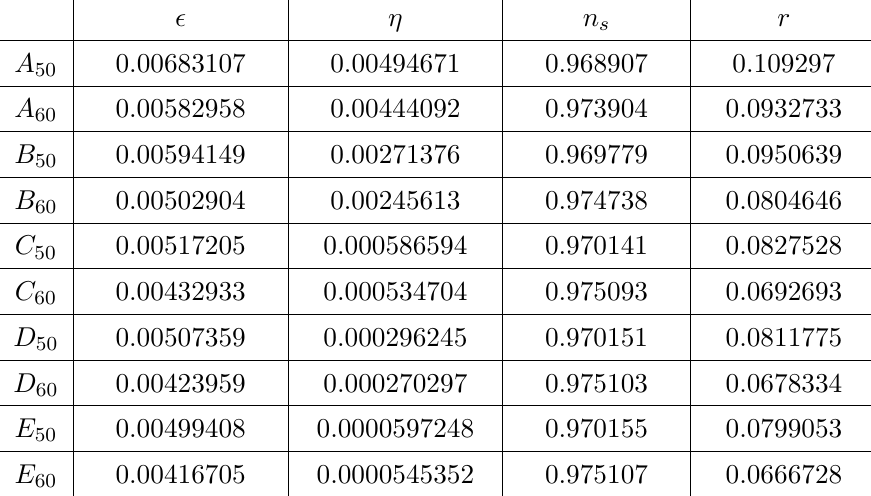
Table 2 . Inflation parameters (cid:15), η, n s , r obtained from our